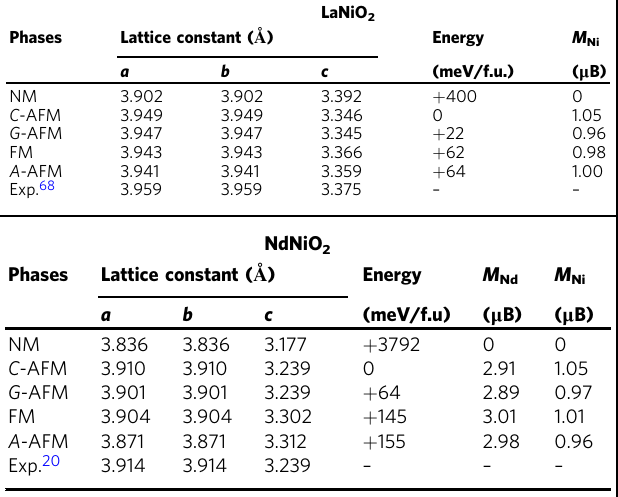
Lattice constants refer to the primitive unit cell. Energies are given relative to the C -type antiferromagnetic phase. Values of magnetic moments display small variations among different NdandNisites,theresultsgivenaretheaveragevalues. M Nd and M Ni denotethelocalmagnetic moment per Nd and Ni atom,